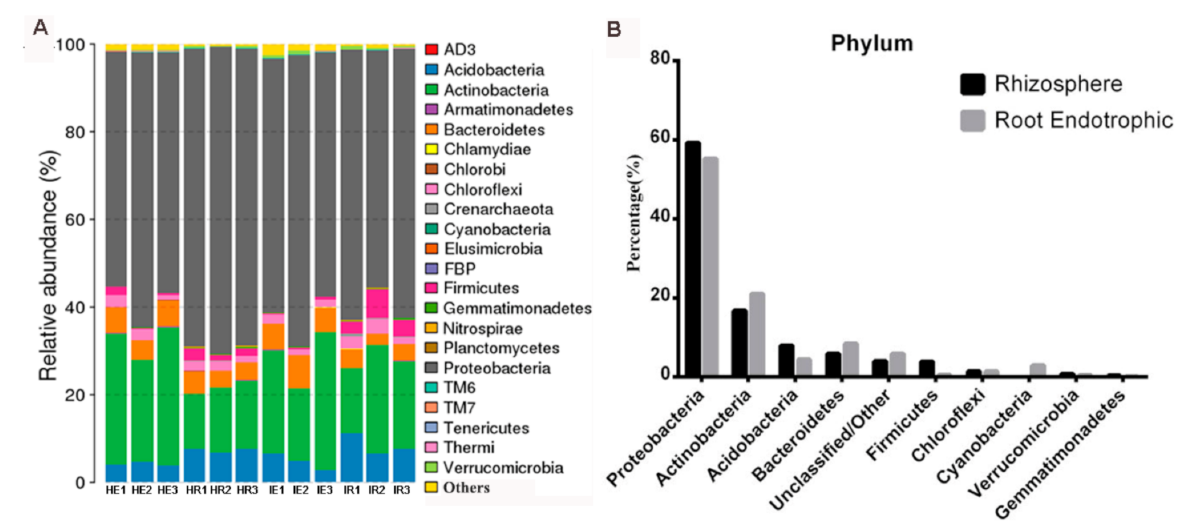
Figure 1. Citrus root endophytic and rhizosphere bacterial community structure. ( A ) Stacked bar graph showing bacteria at phylum level. The ratio of each species in a certain sample is displayed. The phyla with an abundance of less than 0.5% were classified into ‘Others’. ( B ) The distribution of citrus root endophytic (gray) and rhizosphere (black) bacteria for the top ten bacteria phyla. HS: rhizosphere in healthy samples; HE: endophytes in healthy samples; IS: rhizosphere in CLas-infected samples; IE: endophytes in CLas-infected